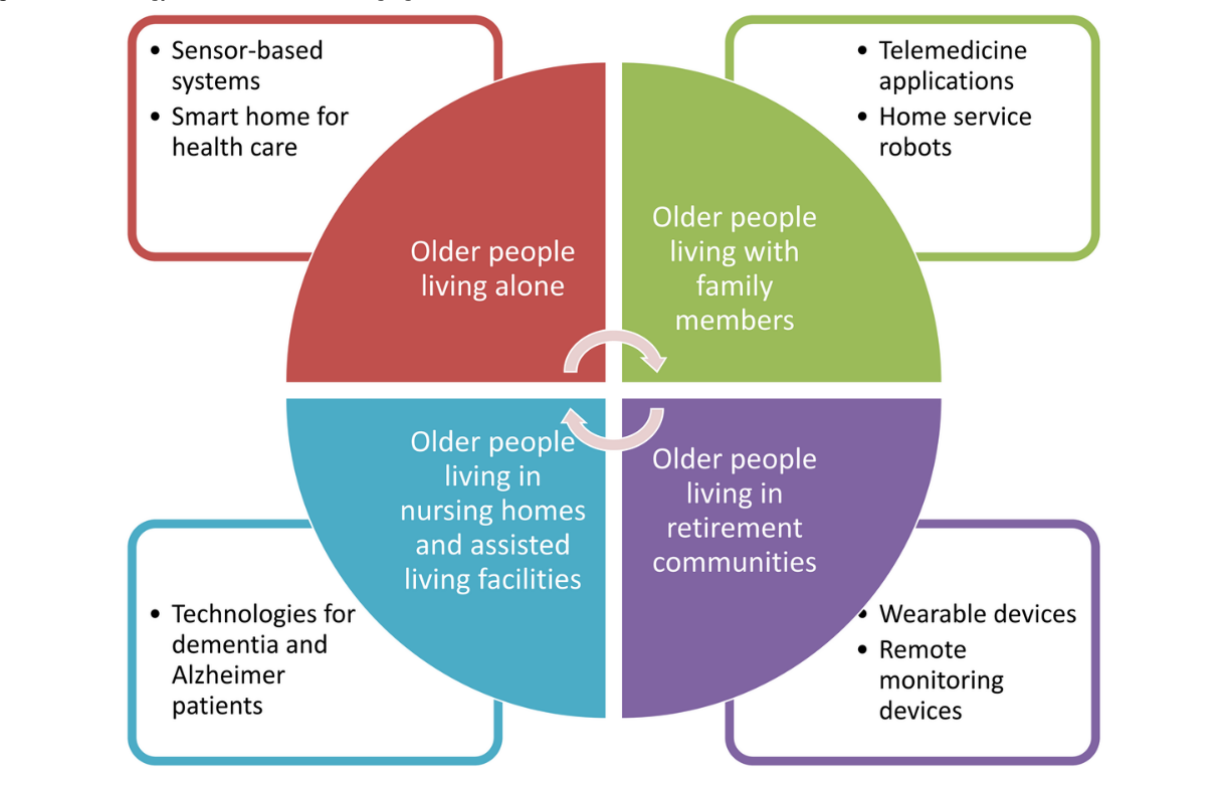
Figure 6. Technology solutions for different aging